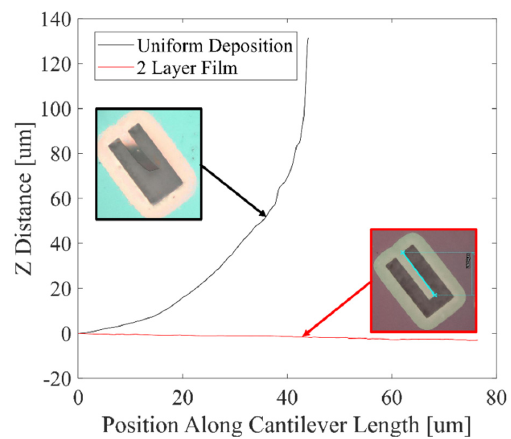
Figure 8. Z deflection for 500 nm PVD sputter-deposited Al 0.68 Sc 0.32 N films where the N 2 process gas flow was applied at constant flow throughout the deposition (black) and a 2-layer 30/20 sccm N 2 flow stack (red).